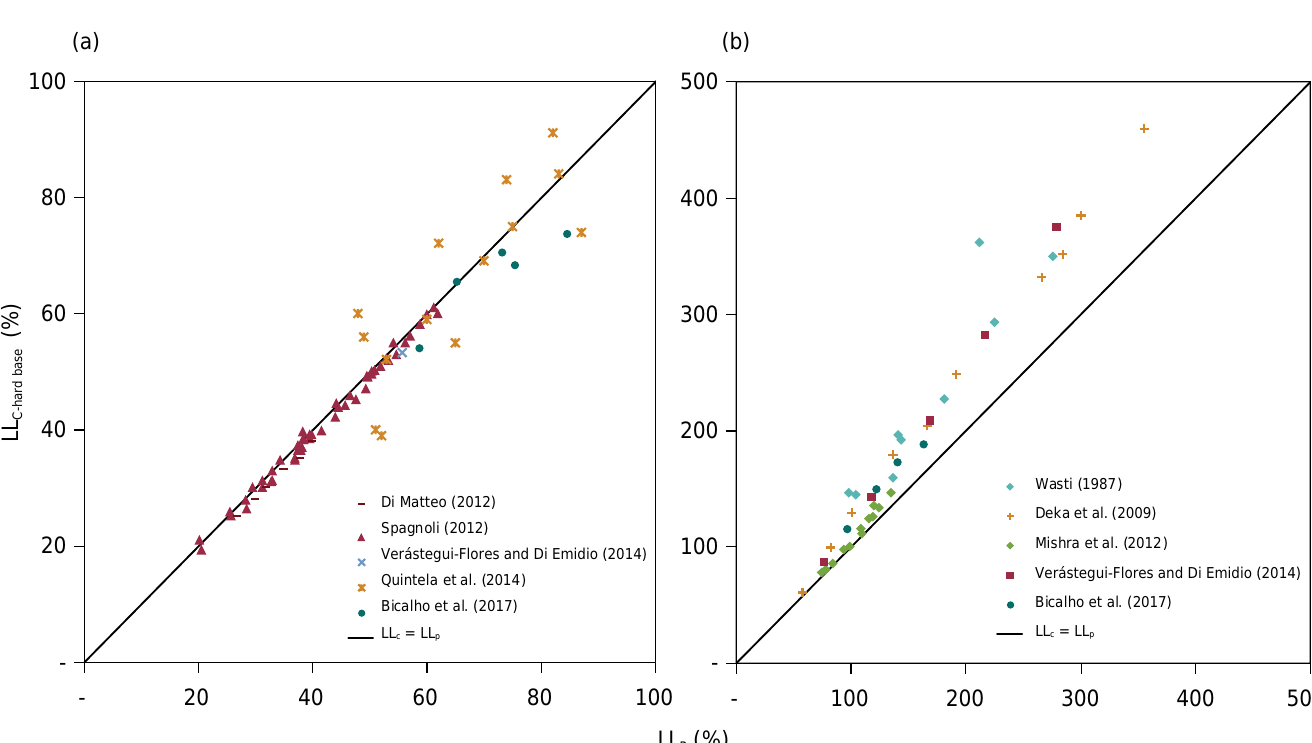
Figure 2. Experimental results (LL p -LL c-hard base ) of the soils investigated in group B-01 in this research: subgroup B-01i with n = 76 formed essentially by kaolinites and illites (a); and subgroup B-01ii with n = 41 consisting essentially of smectites